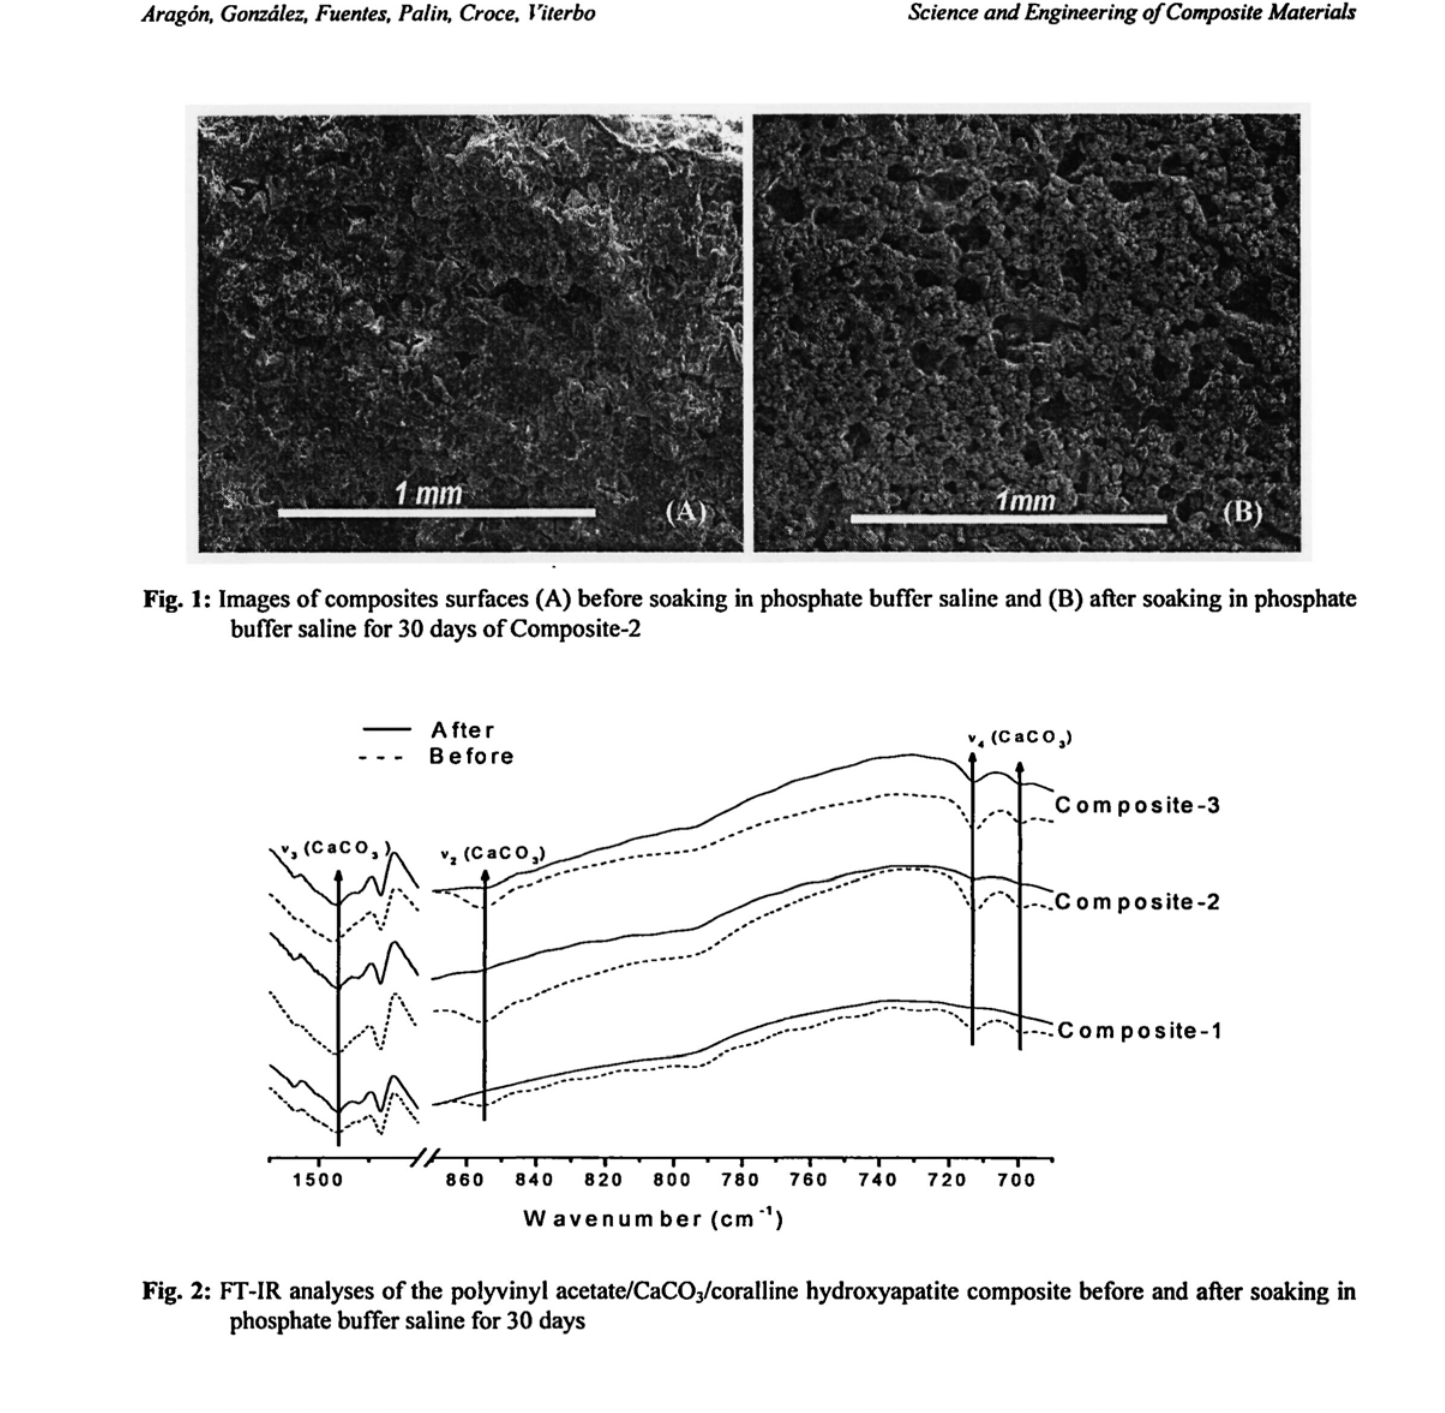
Fig. 2: FT-IR analyses of the polyvinyl acetate/CaCO phosphate buffer saline for 30